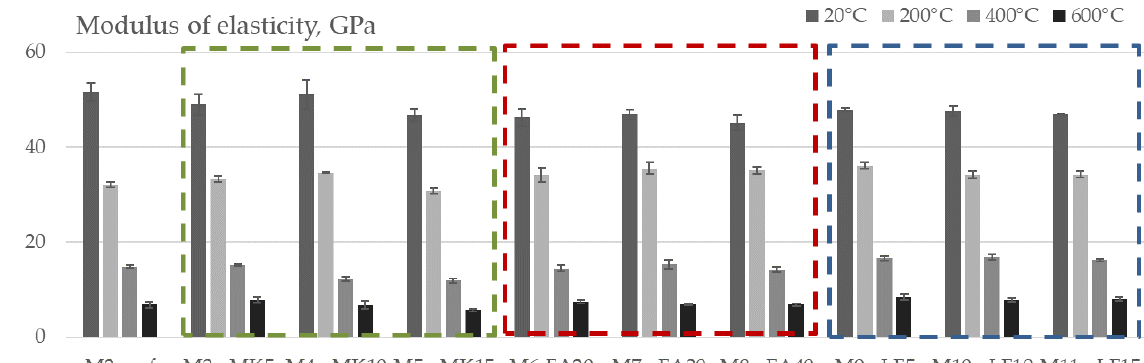
Figure 12. Modulus of elasticity vs. temperature of tested mixes.